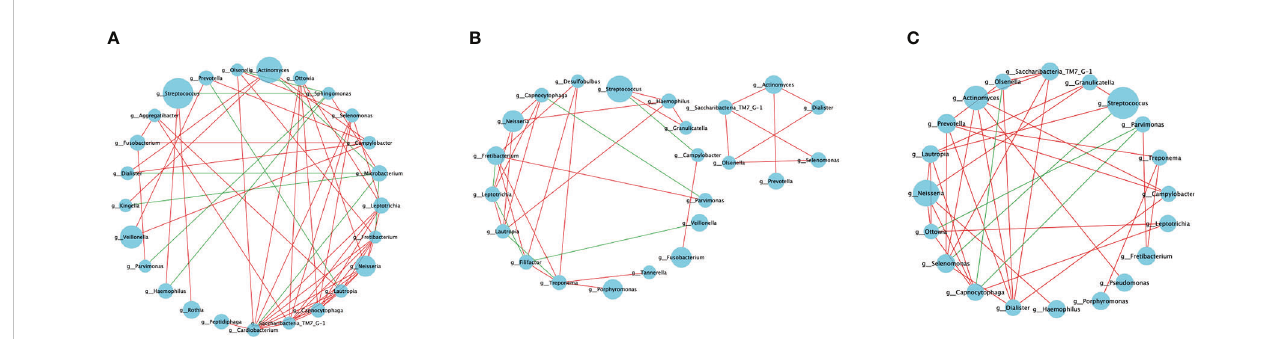
FIGURE 4 Microbial co-occurrence networks. The co-occurrence network of the genera with relative abundance >1% (|SpearmanCoef. >0.5 and p < 0.05). (A) Bacterial interactions in the healthy group. (B) Bacterial interactions in the pre-treatment group. (C) Bacterial interactions in the post-treatment group. The node size represents the abundance of each taxon. The edge color represents positive (red) and negative (green) correlations between the two